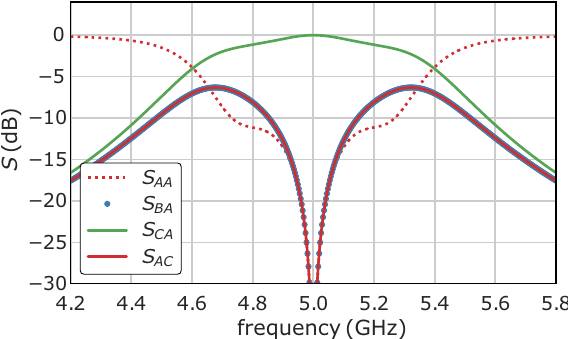
FIG. 5. (a) Coupling graph of a three-mode parametric circu- lator, indicating the relative pump phase, ± π/ 2, of the A - B edge. (b) Corresponding equation-of-motion matrix for a pump phase of π/ 2.